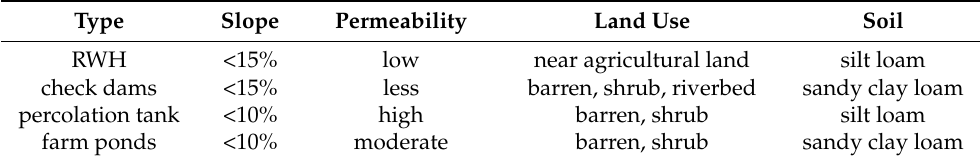
Table 7. Siting differences of catchment